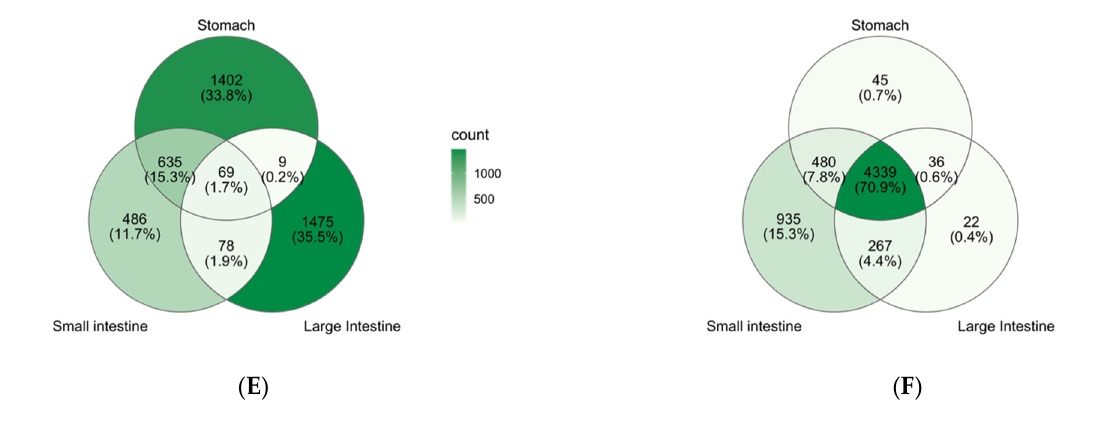
Figure 1. Differences in the microbial community diversity among different regions across the gastrointestinal tract (GIT). ( A , B ) Counts and percentage of unique amplicon sequence variants (ASVs) ( A ) and KOs ( B ) in the stomach, small intestine, and large intestine as well as intersections between groups. ( C , D ) Comparisons of community alpha diversity based on the composition of ASVs ( C ) and KOs ( D ) between the stomach, small intestine, and large intestine. The Wilcoxon rank sum test was performed to test the significance of pairwise comparisons, and p -values were coded as **** ( p < 0.0001), * ( p < 0.05), and ns ( p > 0.05). ( E , F ) Principal coordinate analysis (PCoA) based on the Bray–Curtis distance was used to visualize dissimilarity in the community composition of ASVs ( E ) and KOs ( F ) among different samples. The significance of differences among the stomach, small intestine, and large intestine was determined using permutational multivariate ANOVA (PERMANOVA).